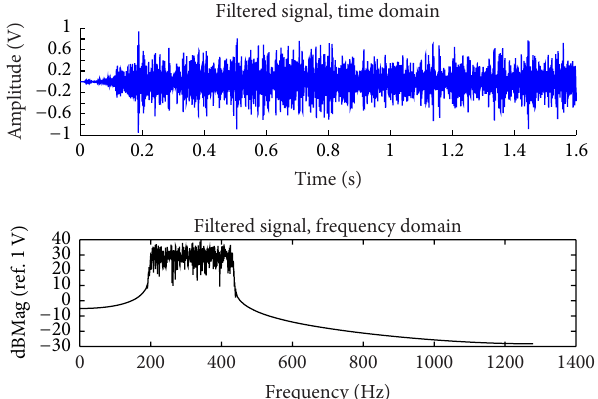
Figure 5: Excitation signal (filtered white noise, 200–430 Hz).